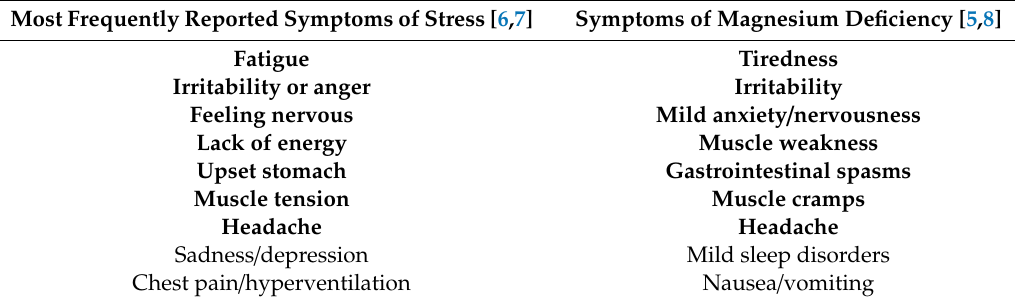
Table 1. Symptoms of magnesium deficiency and symptoms of